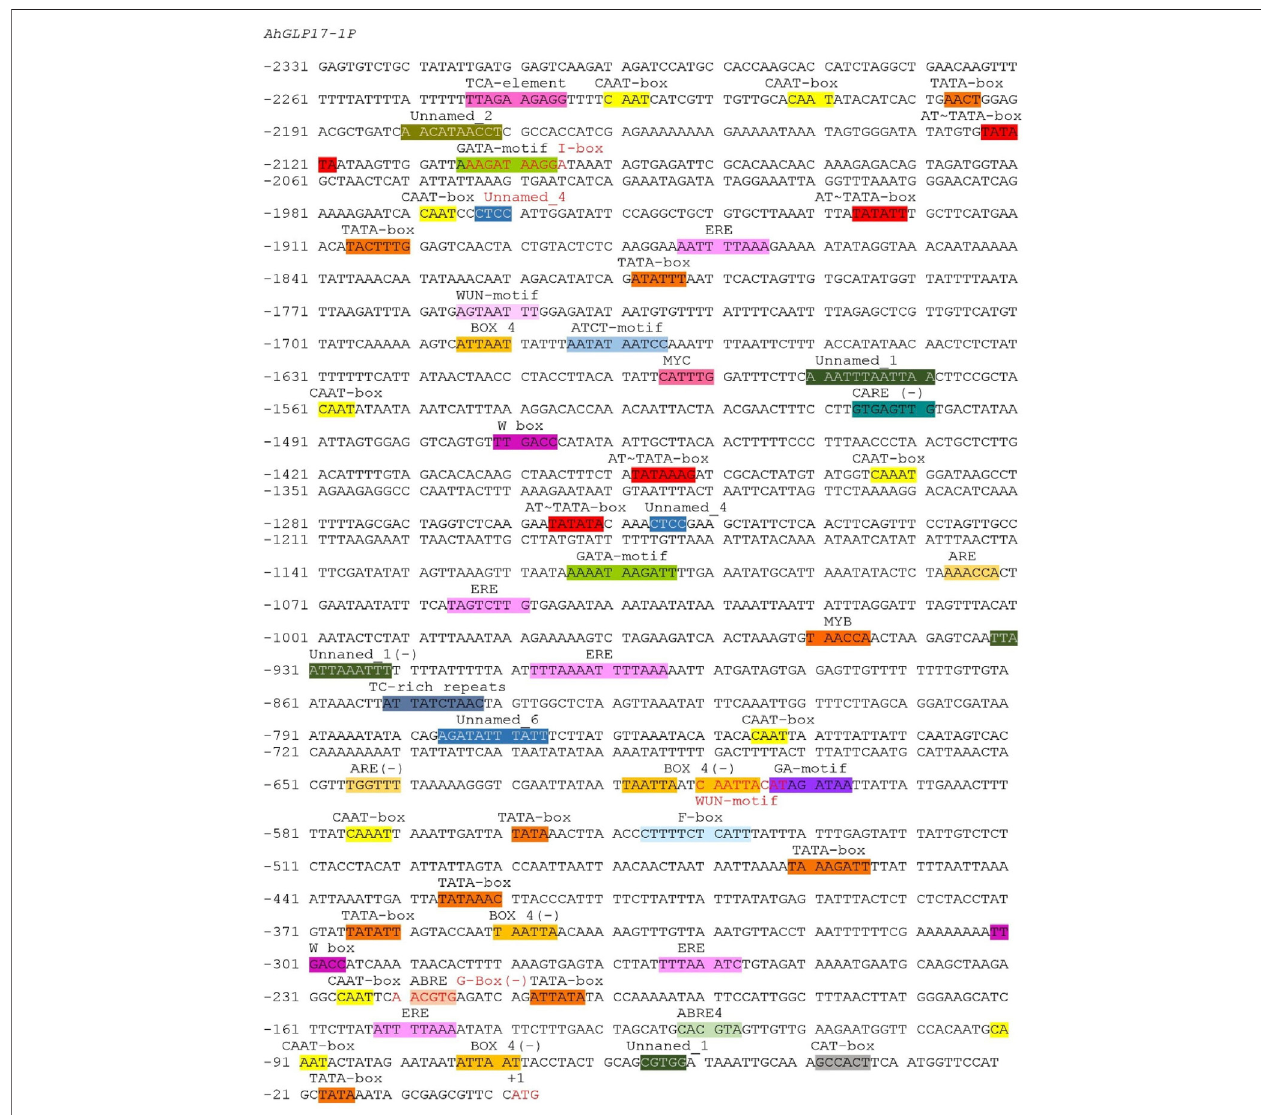
FIGURE 3 | Sequence analysis of AhGLP17-1P promoter. Presence of cis -elements in promoter sequences predicted by the PlantCARE database.